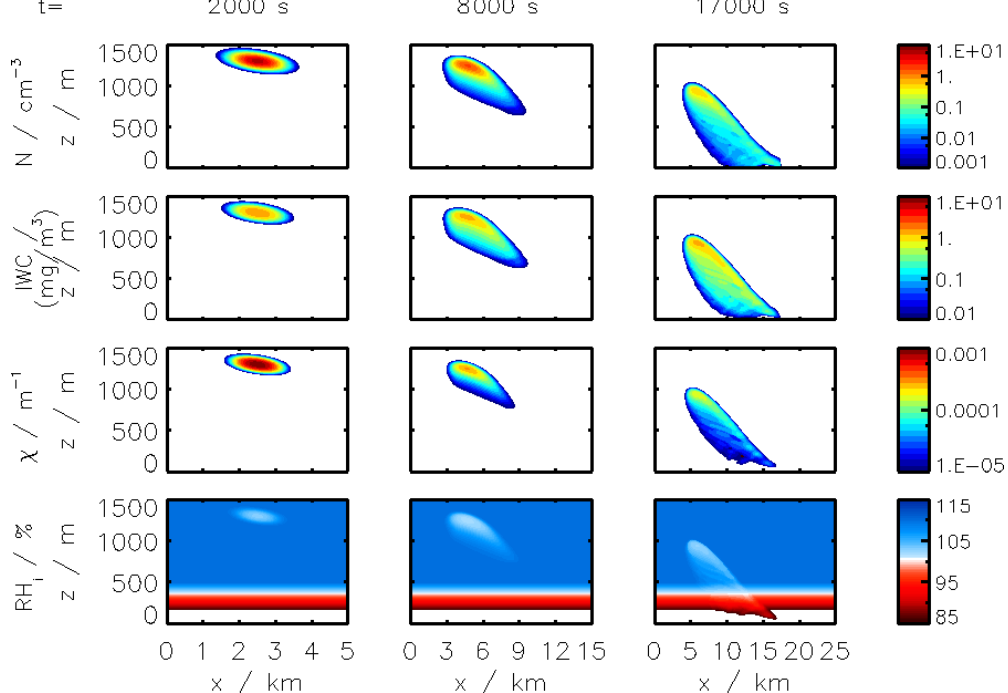
Figure D2. Ice crystal concentration N, ice mass concentration IWC, extinction χ , and relative humidity RH i for the same conditions as described in Unterstrasser and Gierens (2010a). The flight level is at a vertical distance of